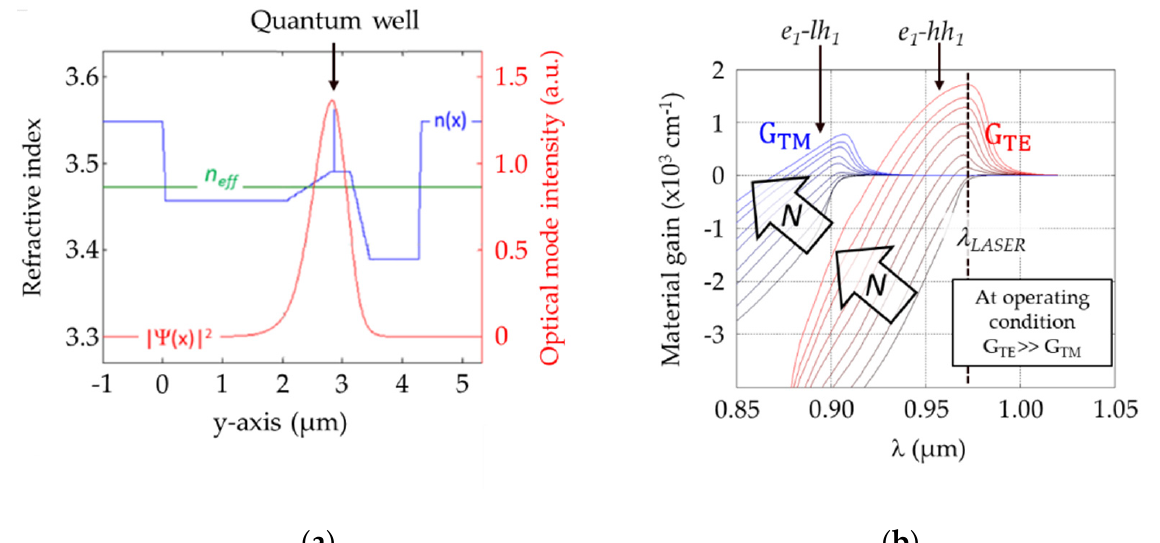
Figure 2. ( a ) Refractive index profile n(x), effective index value n eff and optical mode |Y(x)| 2 . ( b ) TE and TM spectral optical gain calculated at different carrier density N ranging from 1 × 10 17 cm − 3 to 3 × 10 18 cm − 3 .